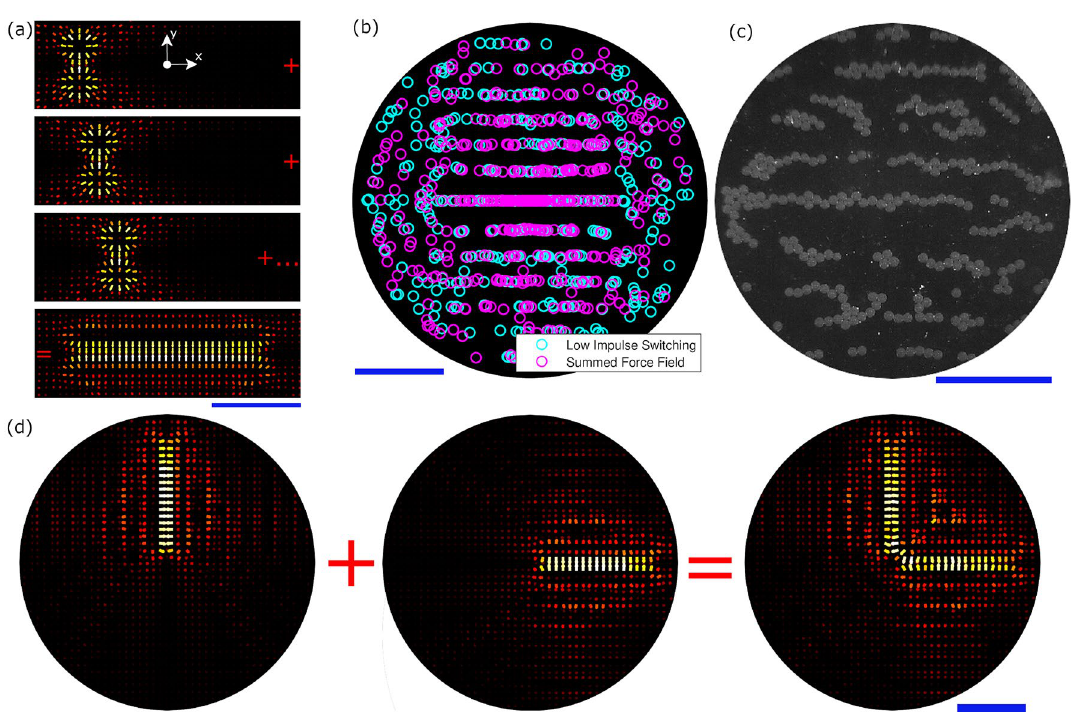
Figure 3. ( a ) Force field summation in the low impulse regime. Each arrow scales both length and colour to the magnitude of the vector at the origin point. A 2 mm line is formed from 10 twin traps. The xy axis is the same as in Fig. 2a with the origin representing the centre of the array. ( b ) demonstrates a simulated comparison of the particle end locations after being exposed to the switched force field or the summed vector field shown in the bottom panel of ( a ). Both fields had a maximum force of 10 nN and in the switched case the (cid:31) t q = 1 ms. ( c ) shows the application of a low impulse switched field to real particles. ( d ) demonstrates the simulated combination of two of these lines to create an ‘L’ shape. Each side of the L-shape is 1.5 mm long and made up of 8 twin traps (16 total). The blue scale bars are 1 cancel out. The low pressure cancellation region can be seen in Fig. 2b and the opposing phases in Fig. 2c; the sources inverted relative to each other are illustrated by the red and blue transducers in Fig. 2a. See “Methods” for more details. Figure 3a shows the process of creating a line feature using a rapid sequence of twin traps. Each trap creates one of the component force states that, when combined, form a linear force field. The first twin trap is specified (cid:31) 1, 0 ) mm and the following twin traps then spaced at approximately x at ( 3 intervals to achieve the desired = − line length (an algorithmic spacing technique detailed in “Methods” was used to enable any line length to be (cid:31) specified, rather than being limited to 3 increments). In this case 10 twin traps are used to produce a 2 mm long line with the resulting force field shown in the bottom panel of Fig. 3a. Focused points and vortex traps were also explored as alternative building blocks for forming a line. The focused points were found to have a the same